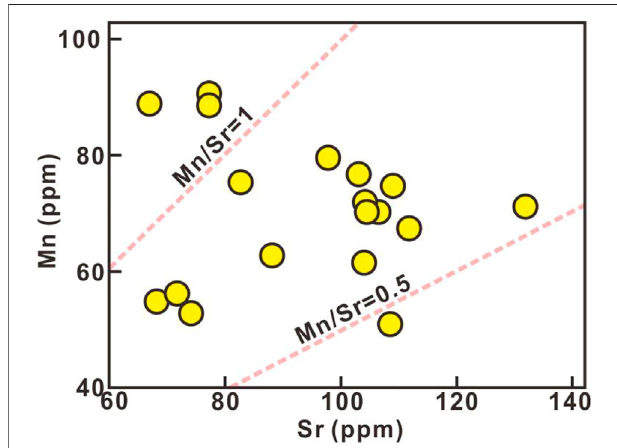
FIGURE 4 | Crossplot showing Mn/Sr ratios of the micritic dolomites.